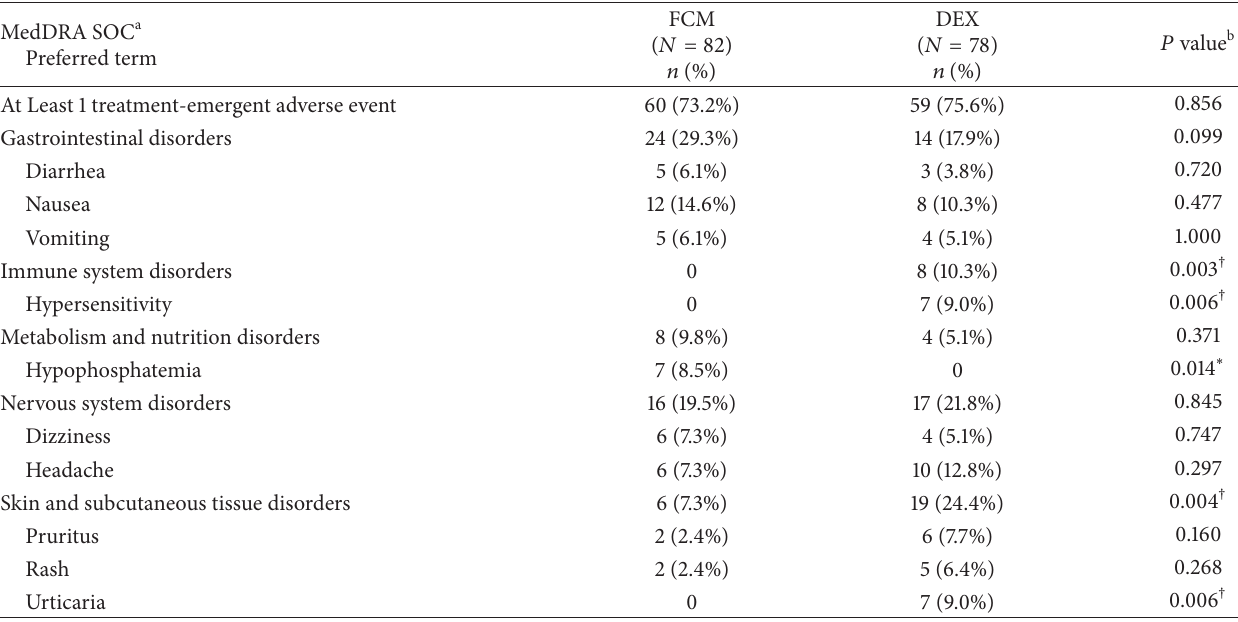
Table 2: Treatment-emergent adverse events experienced by ≥ 5% of patients in either FCM or DEX